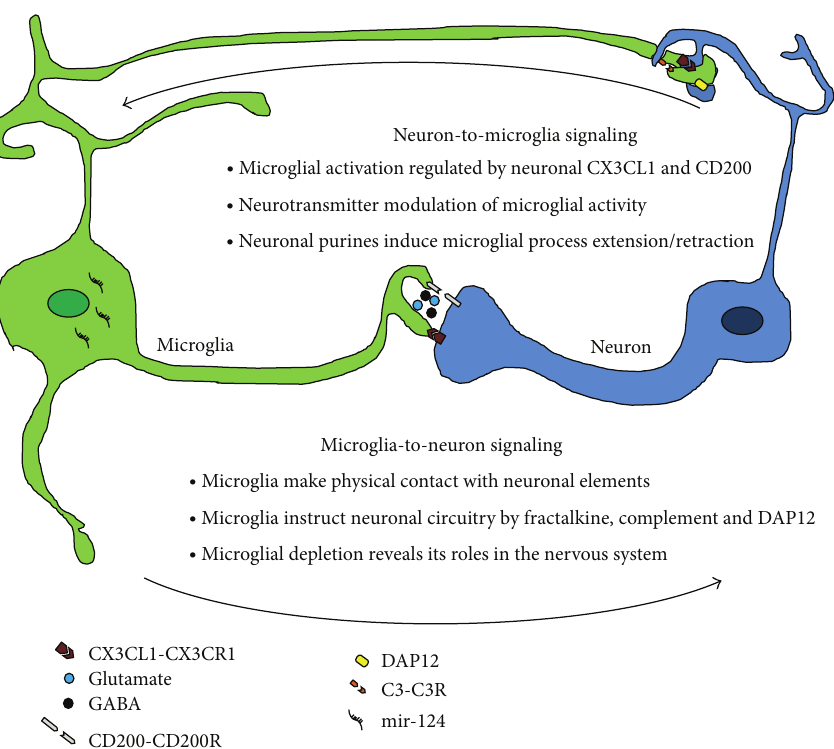
Figure 1: Bidirectional microglia-neuron communication in the healthy brain. Microglia-neuron interactions occur in both directions. Neu- rons can regulate microglial activation state through the unique ligand-receptor pairs (CX3CL1-CX3CR1 and CD200-CD200R), microRNA- 124 (mir-124), neurotransmitters (glutamate and GABA), and purinergic signaling. Conversely, microglia also regulate neuronal activities. It is shown that the microglia is physically making contact with neuronal components. Moreover, fractalkine (CX3CL1-CX3CR1), complement (C3-CR3), and DAP12 signaling which occur distinctively between neurons and microglia are critical for the proper development and maintenance of neuronal circuits. Finally, the roles of microglia in the healthy brain are being elucidated by the several microglial depletion